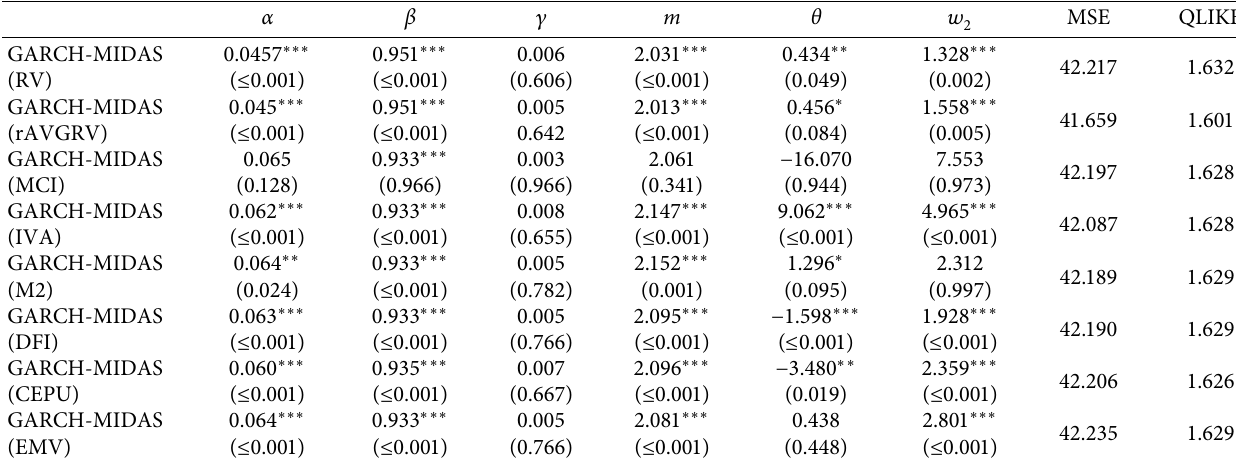
Table 2: Estimation results of single-factor GARCH-MIDAS ( K �